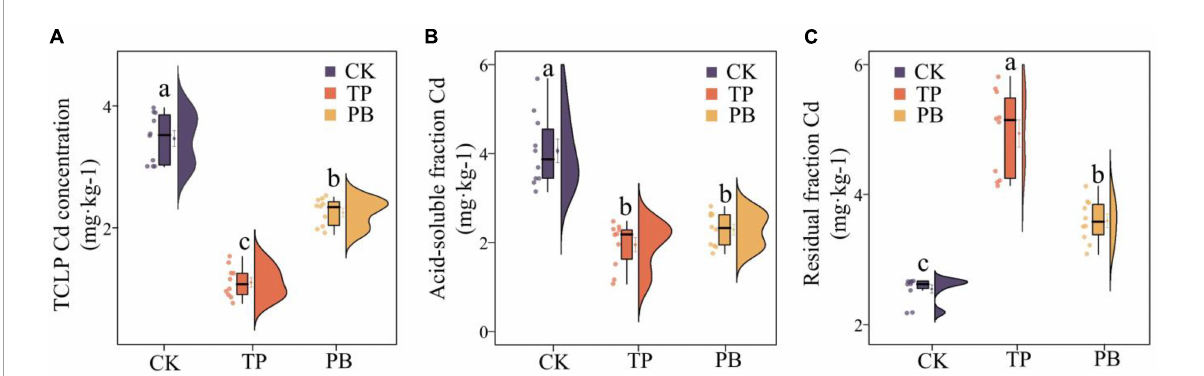
FIGURE1 Leached cadmium (Cd) content (A) and distribution forms of Cd (B,C) in the control group (CK), poplar bark biochar (PB), and thiourea-modified poplar bark biochar (TP) soil treatment groups. Different letters indicate the values that differ significantly among CK, PB, and TP treatments at p < 0.05 [honestly significant difference (HSD)